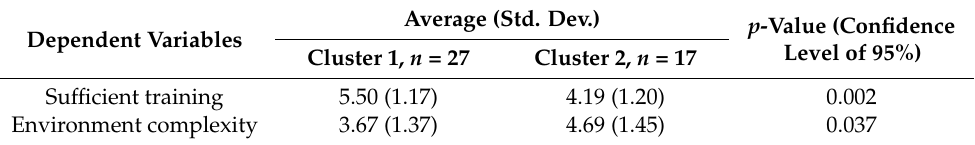
Table 10. Average of the participants’ performance per group and the result of the significance test. Average (Std. Dependent Variables